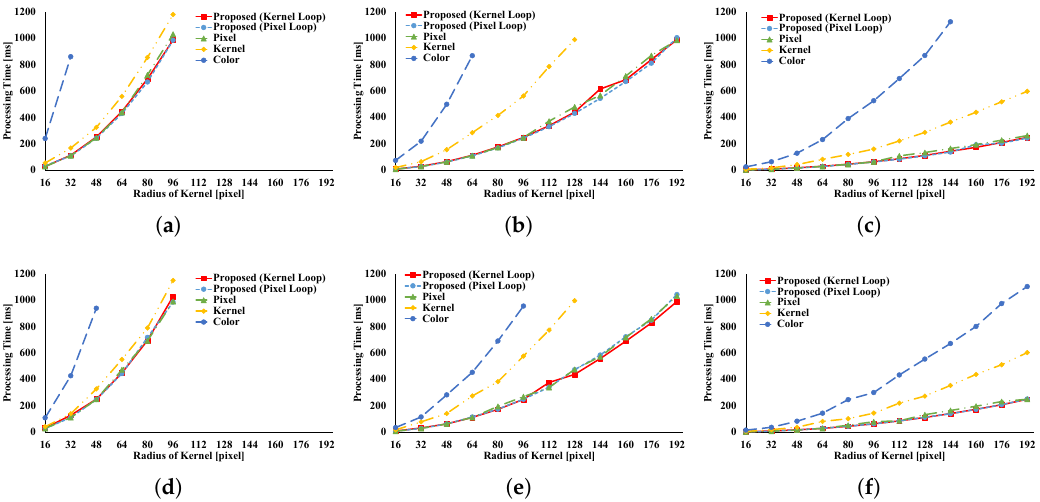
Figure 10. Processing time for bilateral filtering (BF) with respect to the kernel radius of FIR filtering. ( a ) Full sample in weight computation; ( b ) 1/4 subsample in weight computation; ( c ) 1/16 subsample in weight computation; ( d ) Full sample in LUT; ( e ) 1/4 subsample in LUT; ( f ) 1/16 subsample in LUT. Note that arbitrary kernel loop unrolling is used instead of kernel loop unrolling in kernel-subsampling conditions.